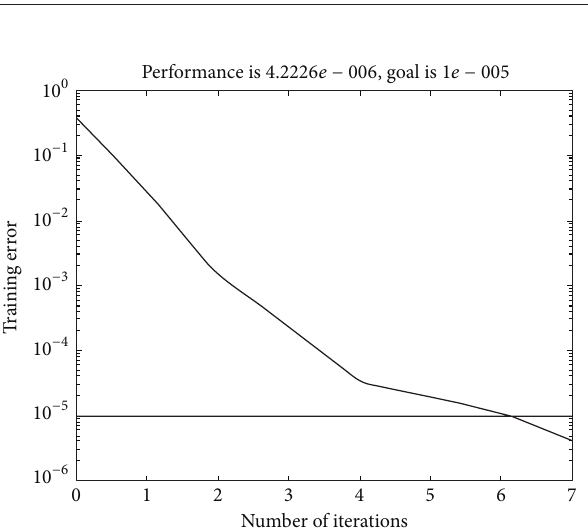
Figure 14: The training process curve of the BPNN method.